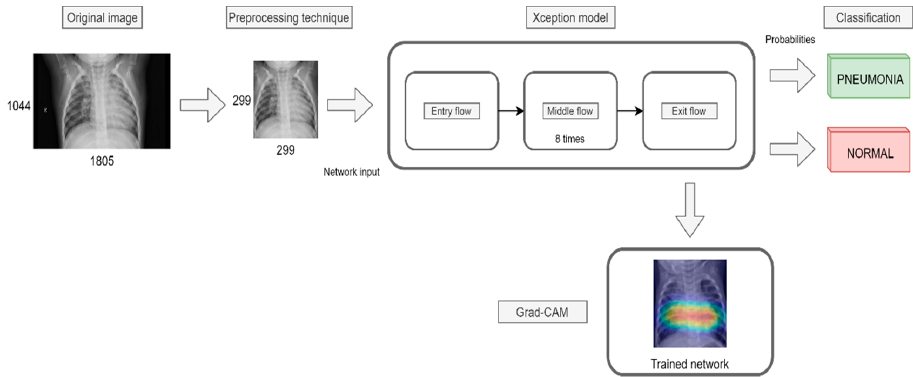
Figure 9. General workflow of the proposed methodology.